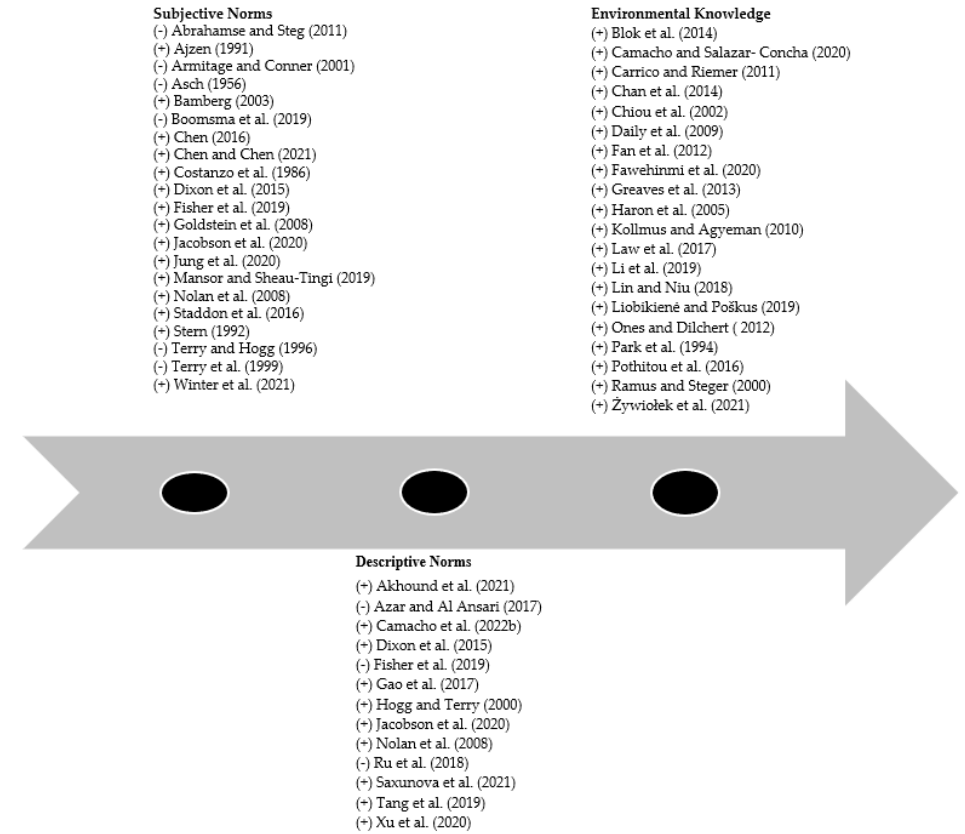
Figure 1. Review of The Related Literature about the Factors on Intention to Save Energy.